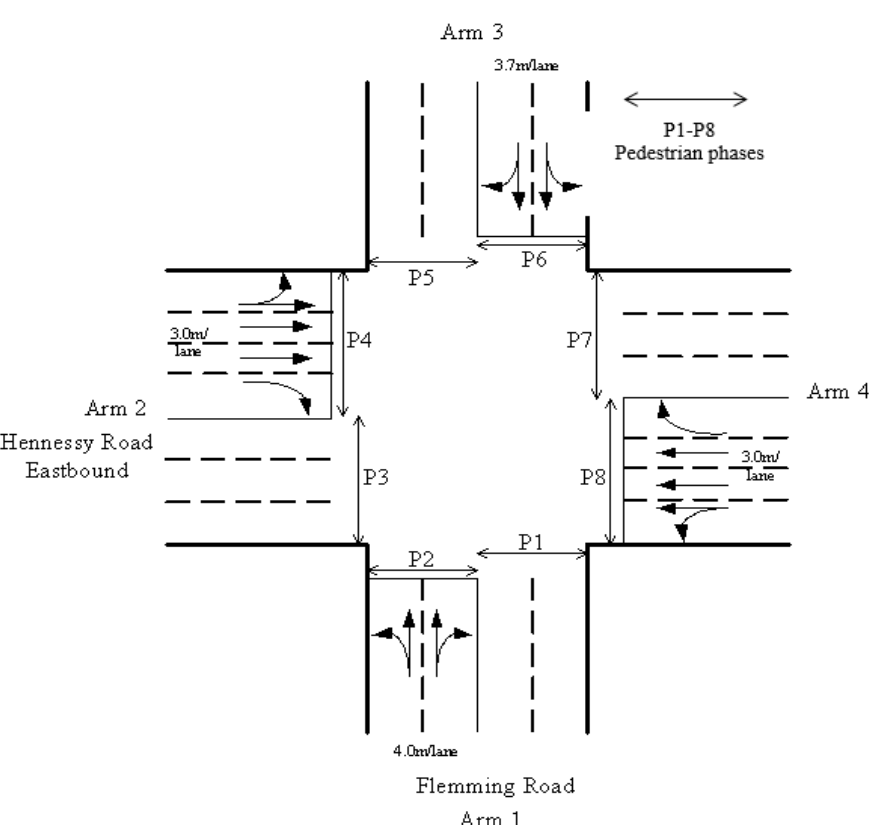
Figure 5. Geometric layout and existing lane markings of the example junction. Table 1. Traffic demand pattern, existing signal settings and junction performances.